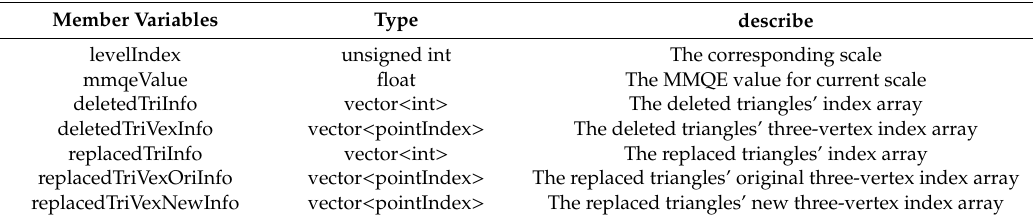
Table 1. Structure of the incremental information type. Member variables, type, description.